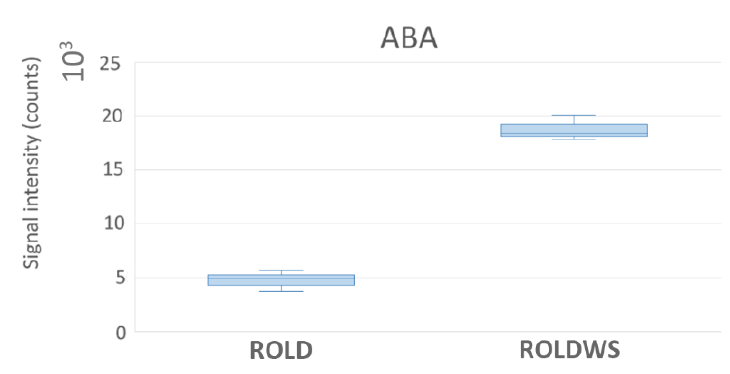
Figure6. Abscisicacid(ABA)levelsinRolDandRolDWSsamples. 10 X Figure 6. Abscisic acid (ABA) levels in RolD and RolDWS samples. 10 X specifies the unit of visualization.